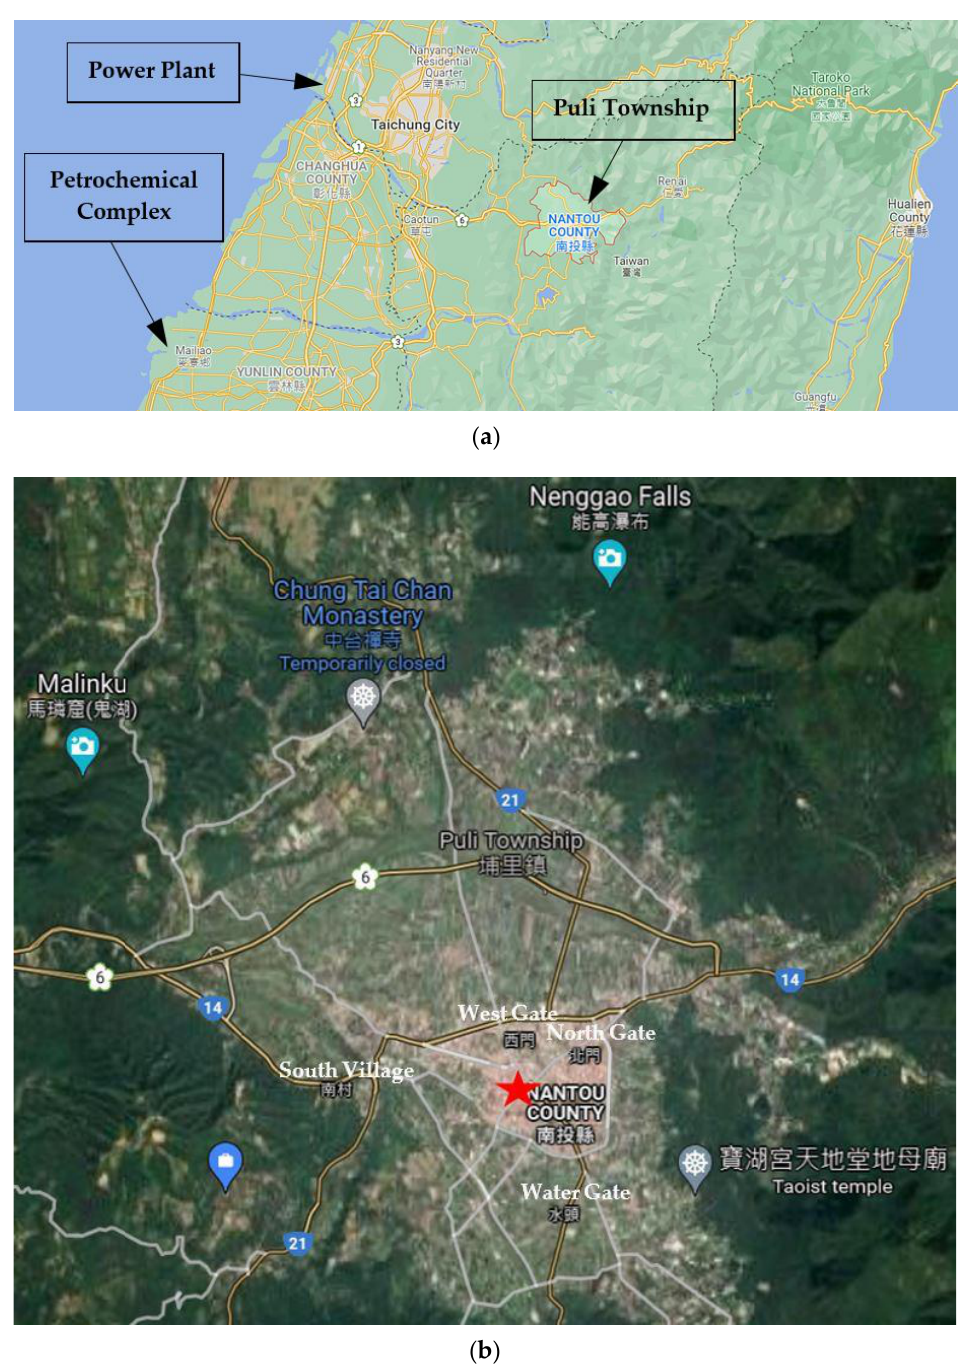
Figure 7. Location of the studied field. ( a ) Puli Township and western plausible pollution sources. ( b ) Basin geography of Puli Township. The EPA supersite marked by a red star is located in the central Puli downtown.